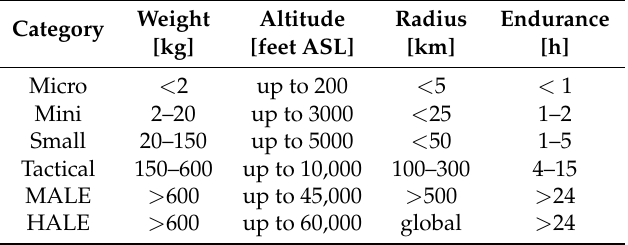
Table 1. UAS classification (according to the Department of Defence), after Qi et al. [18].